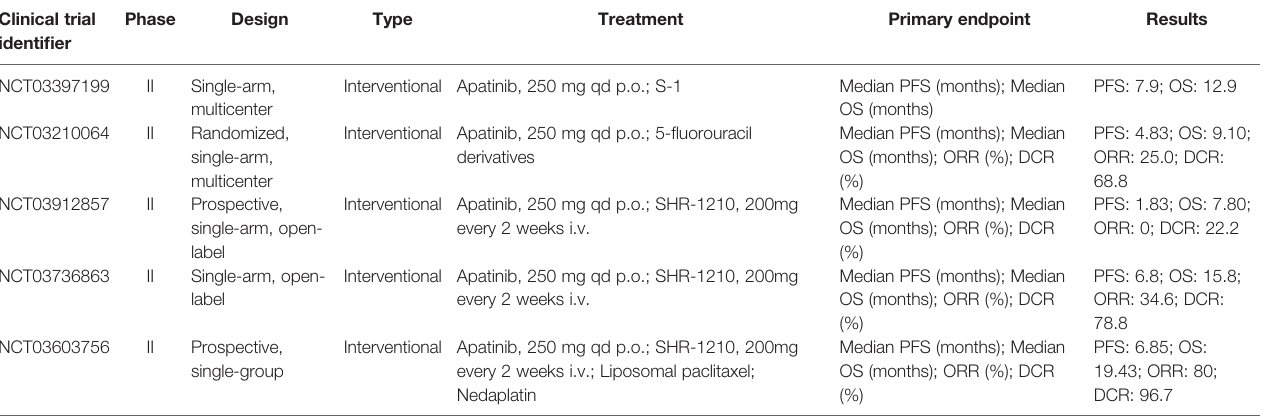
TABLE 3 | Selected clinical trials with apatinib in colorectal cancer and esophageal squamous cell carcinoma. Clinical trial identi fi